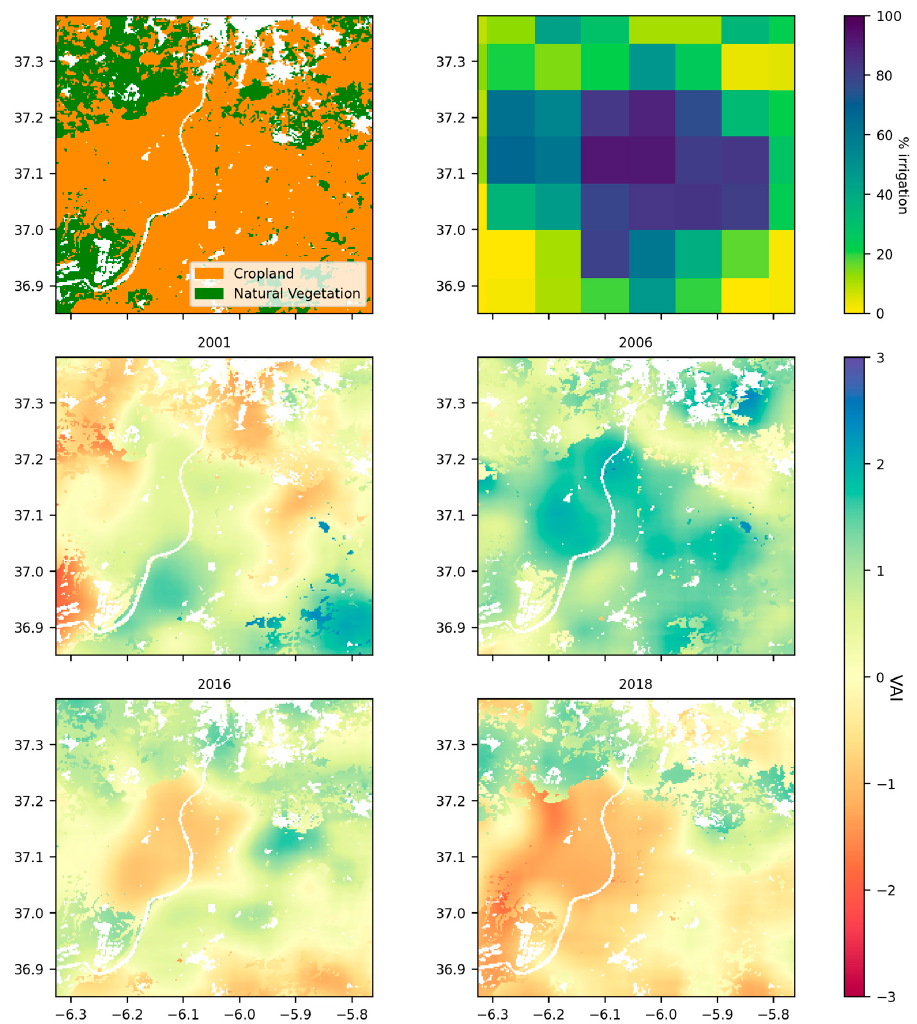
Figure 8. Maps of land use, irrigation, and VAI for March 2001, March 2006, March 2016, and March 2018 over the Andalusia site.